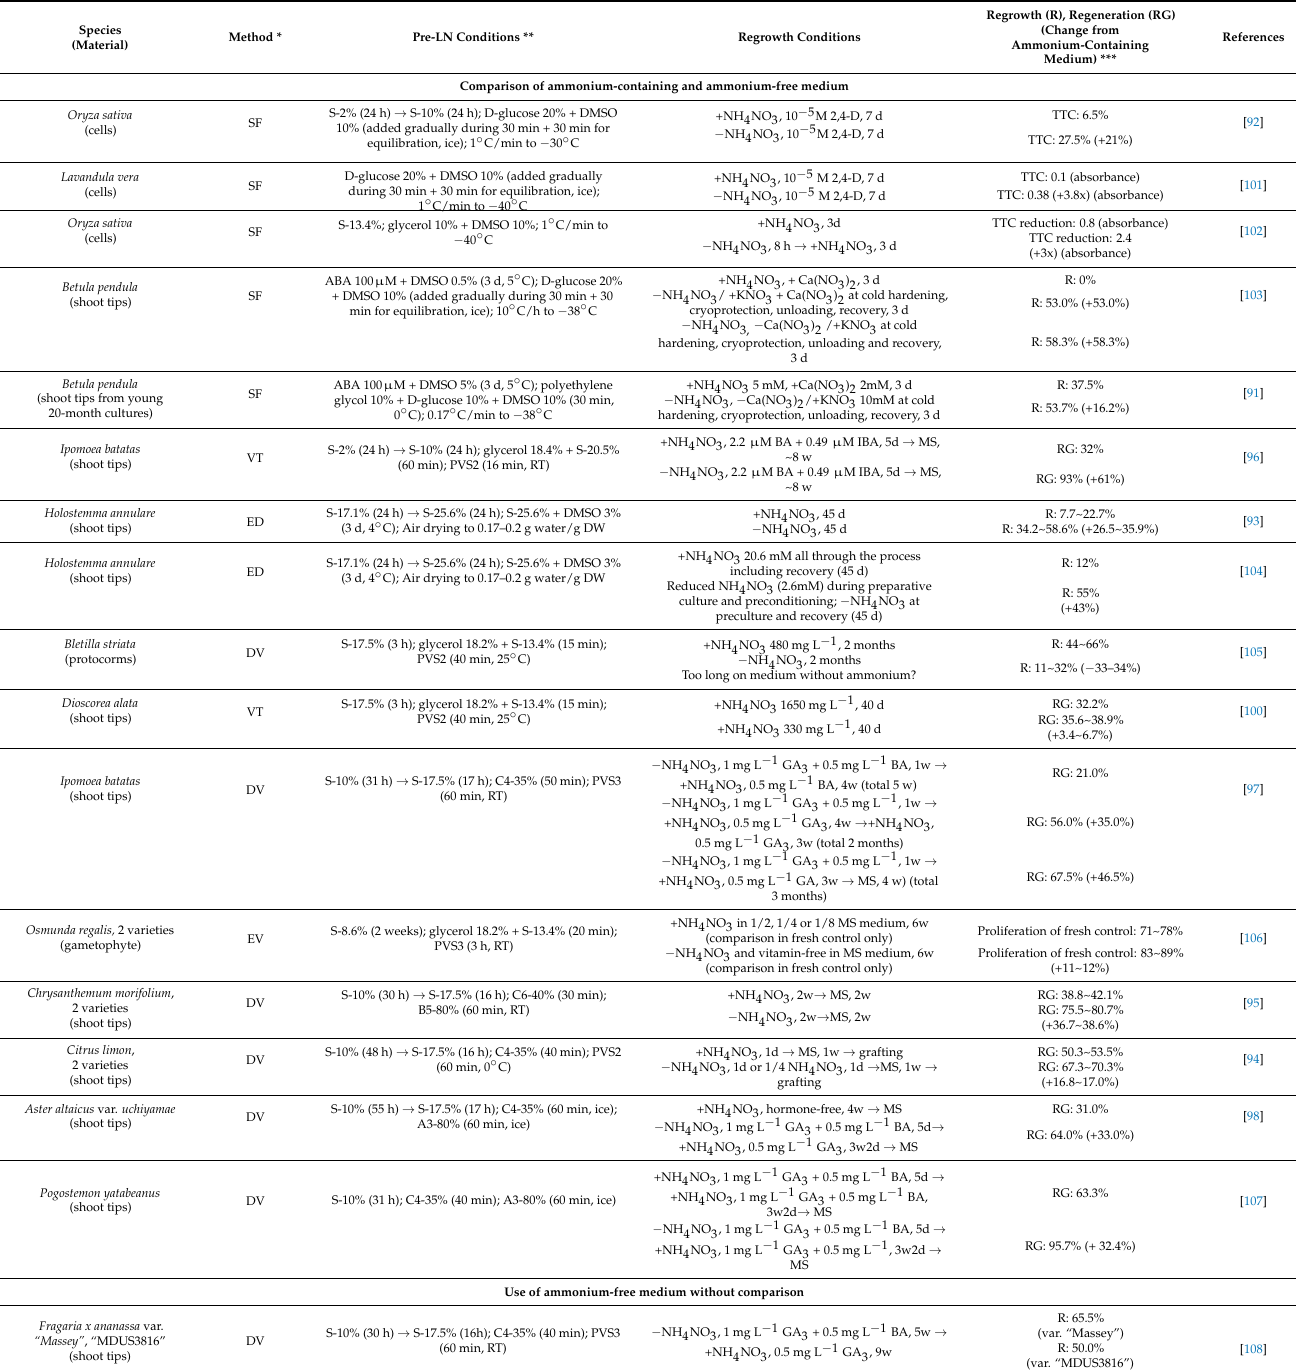
Table 1. Examples of cryopreservation studies using ammonium-free regrowth